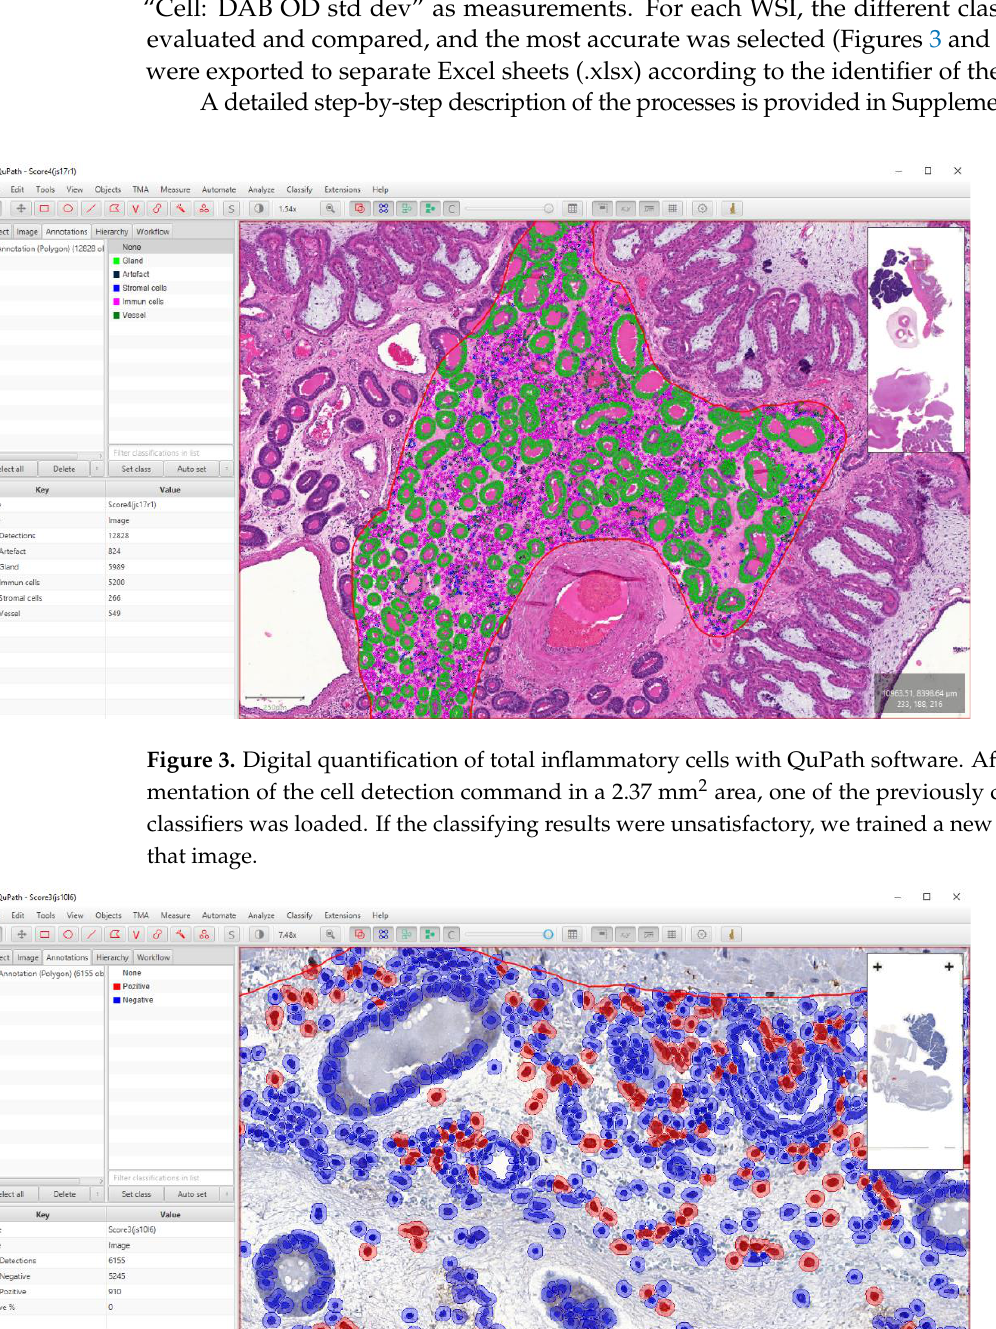
Figure 2. Digital quantification of total inflammatory cells with QuPath software. To train the object classifiers, we manually set the detected cells into the corresponding classes in a 1 mm 2 area.